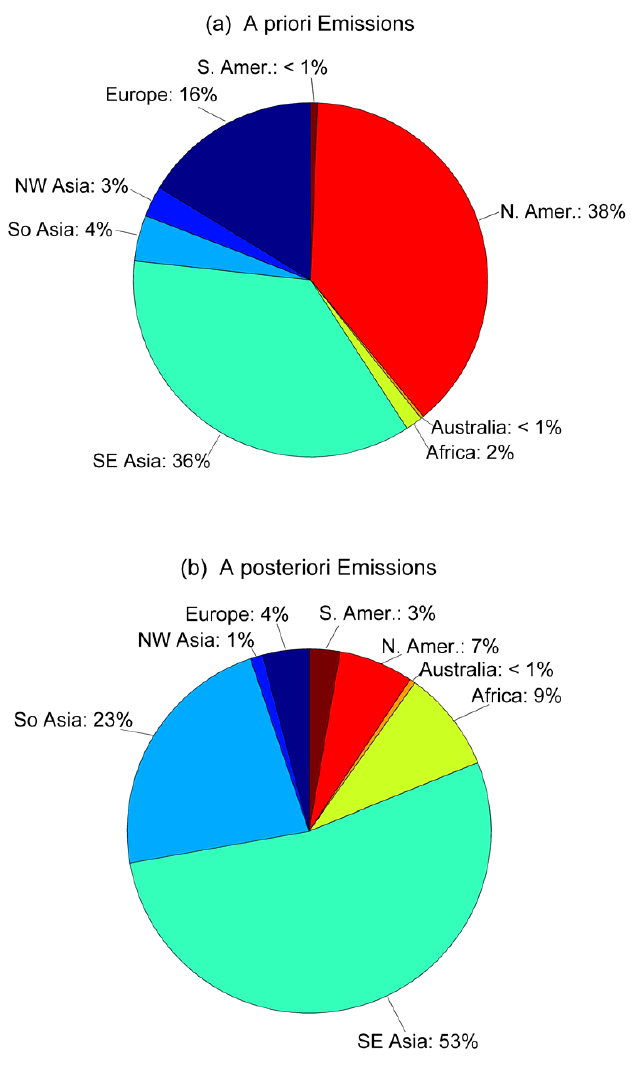
Fig. 8. (a) A priori and (b) a posteriori regional contributions to the global industrial emissions of CCl 4 .